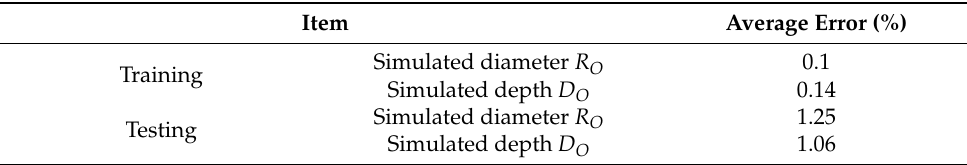
Table 7. Training and testing error for the SLDM.